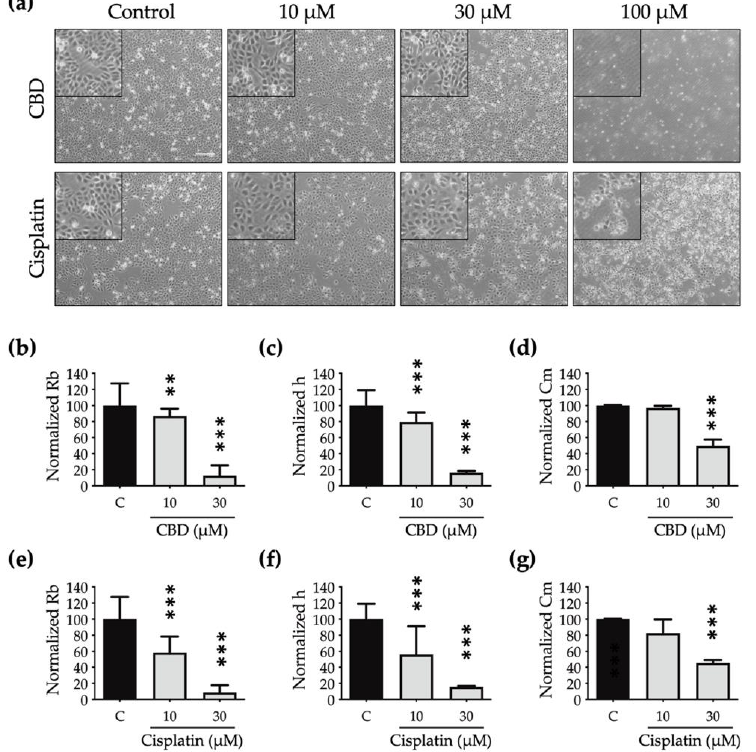
Figure 4. Effect of CBD and cisplatin on the cell morphology of OEC-M1 cells: ( a ) Images of OEC-M1 cells that are exposed to CBD and cisplatin at 10, 30, and 100 μM at the 24th hour from a phase-contrast microscope. Scale bar, 200 µm. The changes in the morphological parameters of the normalized junctional resistance between cells (Rb), the average cell – substrate separation (h), and the membrane capacitance (Cm) were measured using the cell-electrode model calculation for cell resistance data. The histogram shows the changes in the normalized Rb, h, and Cm values for OEC-M1 cells after treatment with ( b – d ) CBD and ( e – g ) cisplati n at 10 and 30 μM for 24 h. All data are represented as mean ± standard error mean (SEM) for at least three independent experiments. ** p < 0.01; *** p < 0.001 as compared with the control group.